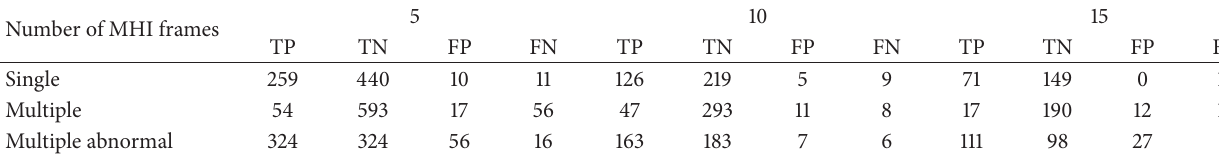
Table 4: TP, TN, FP, and FN of all classes of our testing data set.